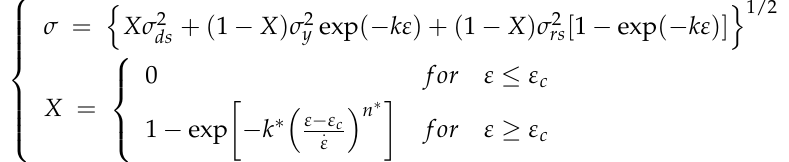
Figure 15. The relationships between σ y , σ rs and the Z parameter. The linear curves are obtained from linear fitting.